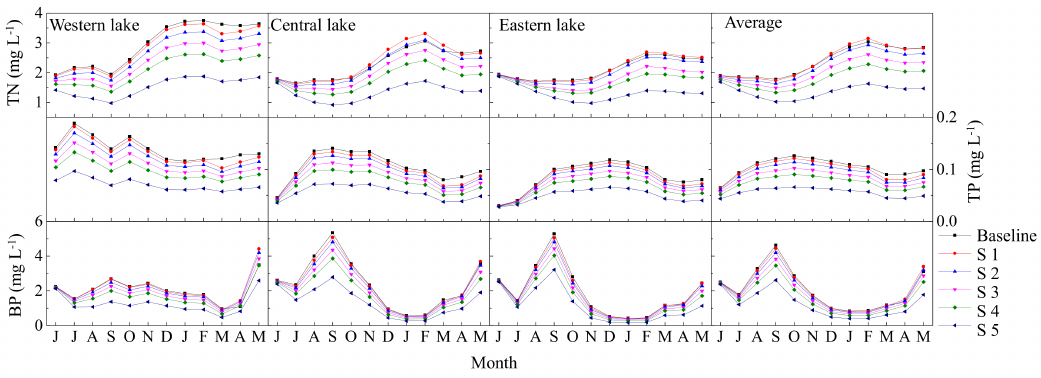
Figure 7. The concentration of TN, TP, and BP in Lake Yangchenghu under different nutrient proportions of baseline load in influent rivers.